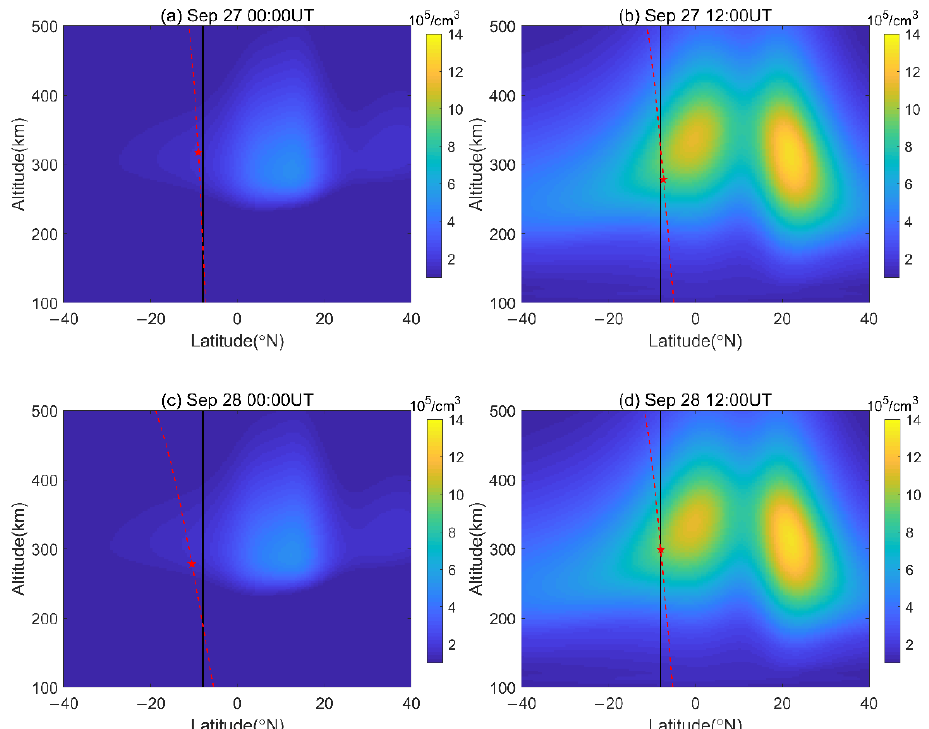
Figure 11. Snapshots of ionospheric electron density on the meridian plane along the longitude of the Ascension Island station obtained from the IRI-2016 model. The black vertical lines denote the Ascension Island latitude line; the red dashed lines are the lines between the tangent points of RO ray paths; and the pentagrams represent the location of the maximum electron density.